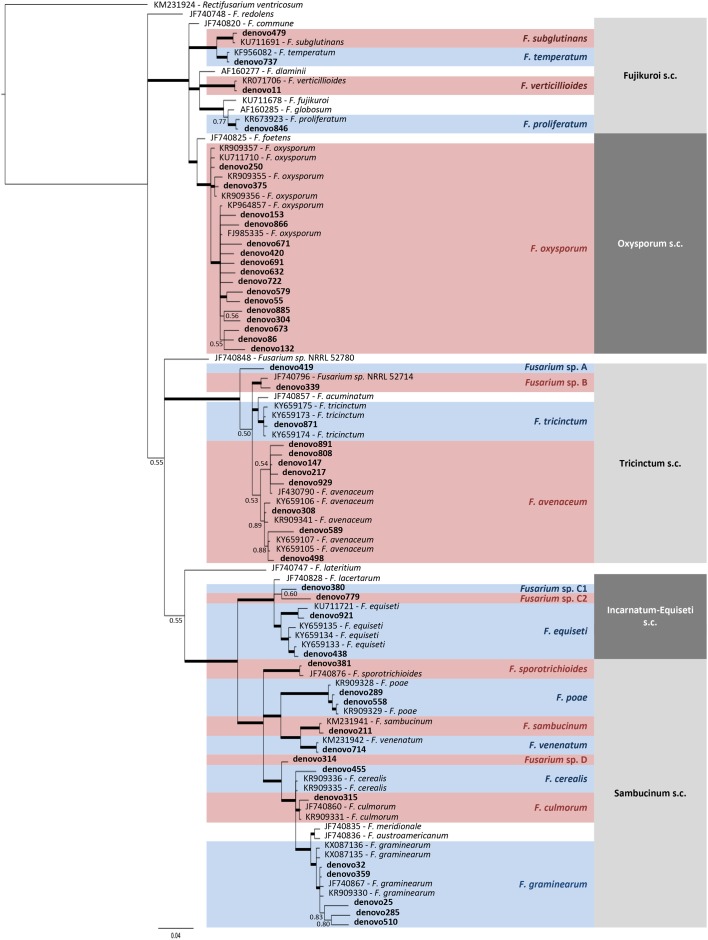
Phylogenetic tree of TEF1 sequences from Fusarium OTUs and reference isolates, which accession number was indicated. Bayesian posterior probability (BPP) values (above 0.50) are shown at the nodes. The thickened nodes represent BPP values higher than 0.9.